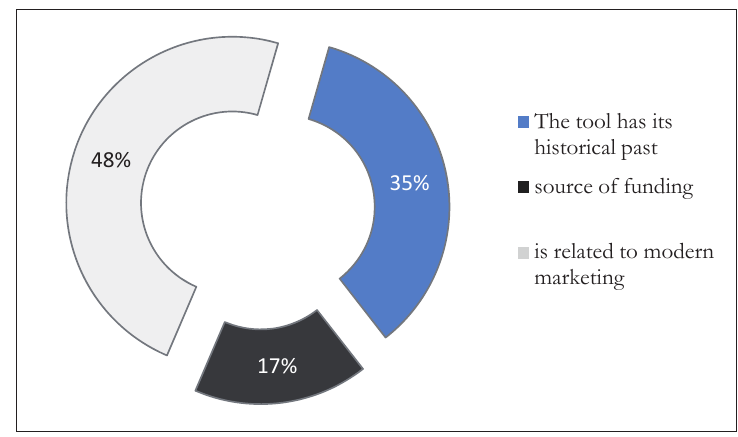
Fig. 2 – The term of product placement has most frequently been associated with three areas. Source: author. The term of product placement has most frequently been associated with three